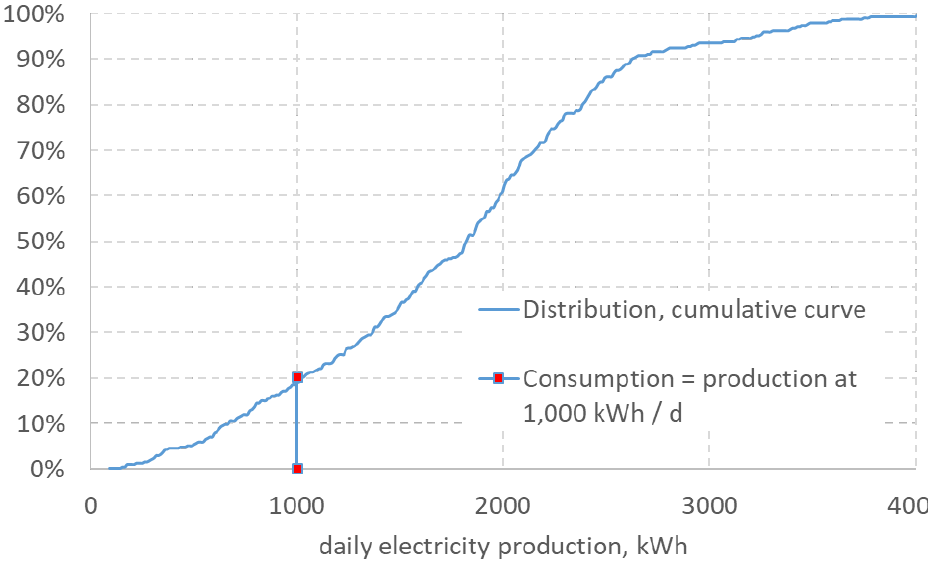
Figure 5. Distribution of daily output of a combination of wind turbine (60.8 KWp) and PV system (182.5 KWp) in 2012; daily consumption 1000 kWh, annual 365,000 kWh.